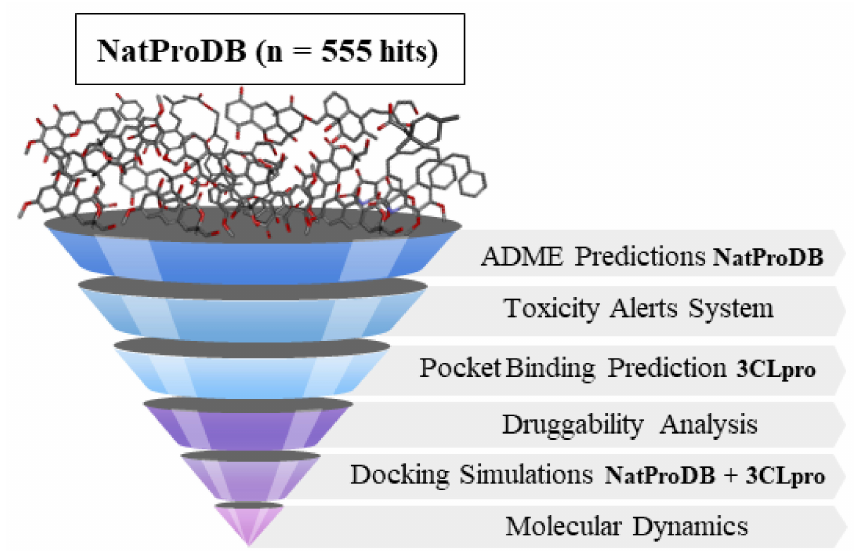
Figure 1. Virtual screening steps applied in this study to identify new compounds from NatProdB (555 hits) with potential antiviral activity against the SARS-CoV-2 Main protease, including: ADME property filters; toxicity alert filter for chemical groups; and docking simulations and molecular dynamics